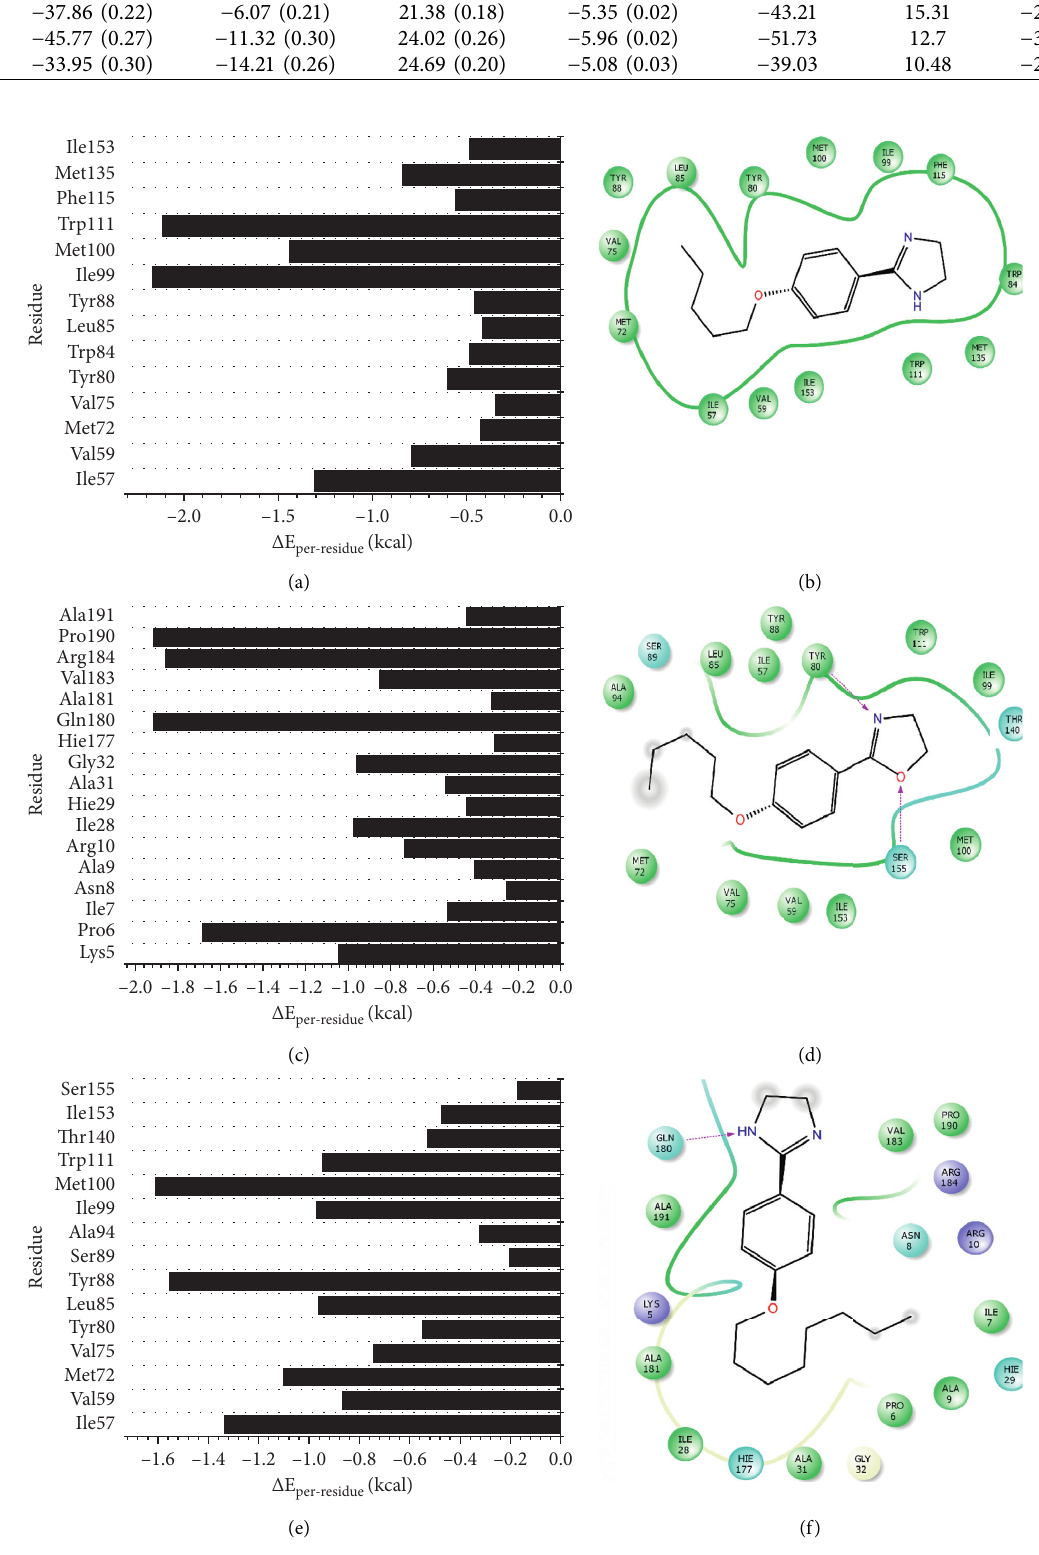
Figure 16: Per-residue free energy ( Δ E per-residue ) and map of interactions for the most populated conformation of the CviR- 13 (a and b), CviR- 16 (c and d), and CviR- 14 (e and f) complexes. The map of interactions was constructed with Maestro Schr¨odinger version 10.5